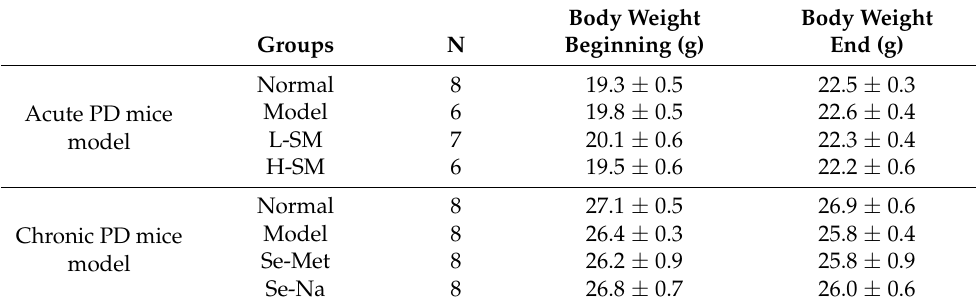
Table 1. Body weight and final animal numbers in each